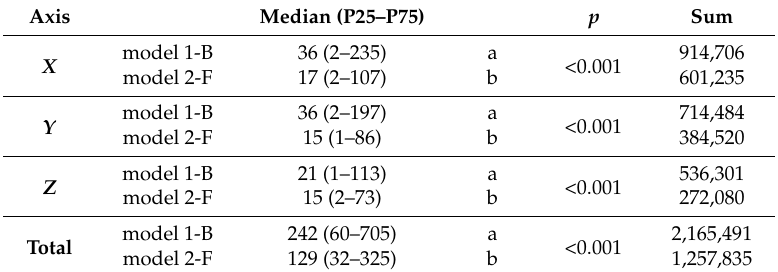
Table 5. Comparison of the values of the square of the X-deviation, Y-deviation, Z-deviation, and the total in the impressions of the open tray impression groups for dragging copings, without splitting, and with and without angulation (groups B and F, respectively).